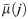
The mean firing count and its Fano factor.(A, B) Temporal changes in the mean μ¯(j) of the firing count of an excitatory neuron and an inhibitory neuron in the second module. With the release of ACh, i.e., with the decrease in REI, the firing rate increases. (C, D) Temporal changes in the Fano factor F(j) of the firing count of an excitatory neuron and an inhibitory neuron in the second module. With the release of ACh, the Fano factor decreases.